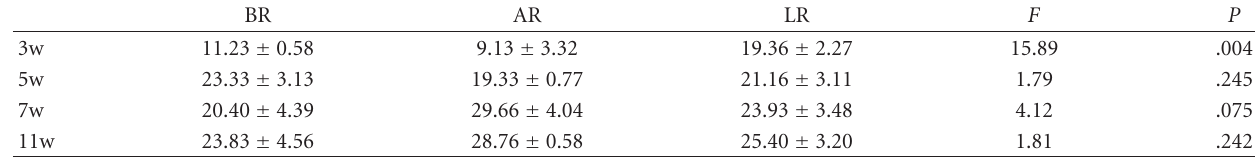
Table 5: The express level of the CD3 + CD4 + T cells of each group in di ff erent development stage (Mean ± SD) ( N = 5). BR AR LR F P 3w 34.67 ± 8.04